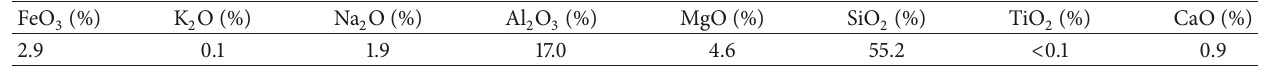
Table 4: Typical chemical composition of OCMA grade bentonite.